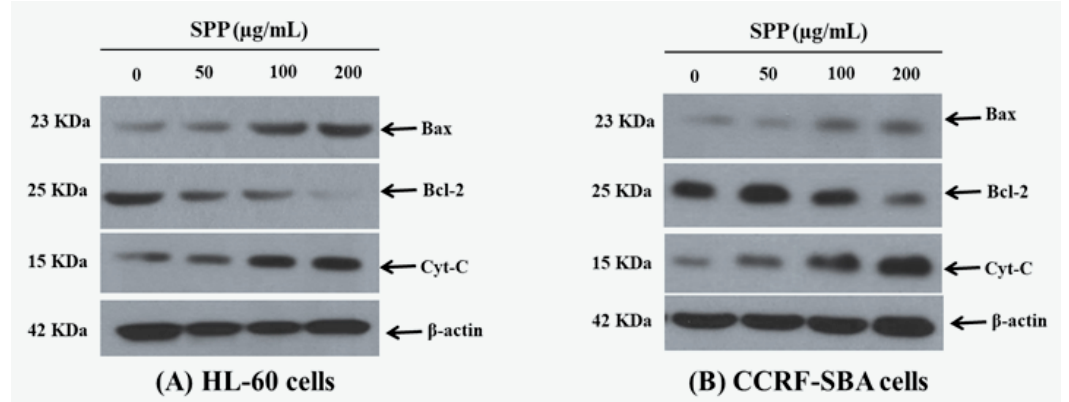
Figure 4. Effects of SPP on regulation of Bcl-2 family proteins of HL-60 ( A ) and CCRF-SBA cells ( B ). Data are representative of three independent experiments.